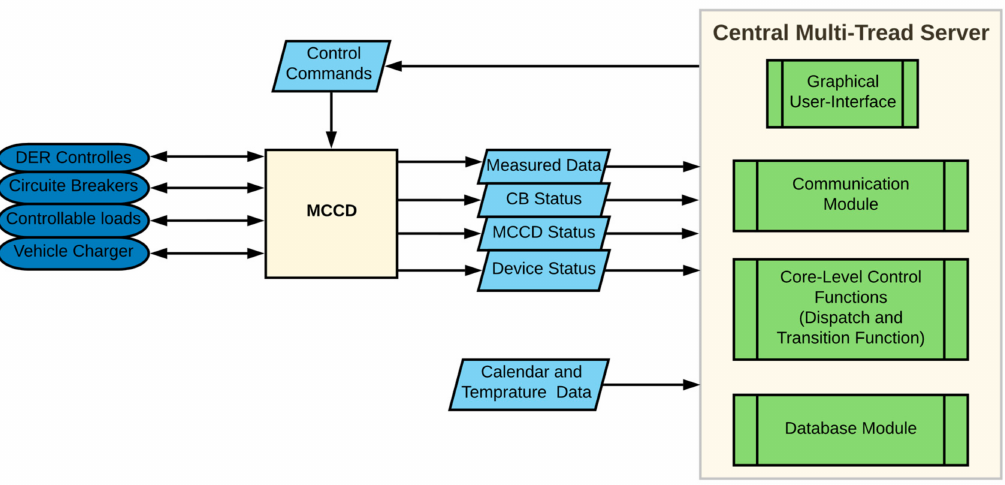
Figure 3. Data flow and interaction within main parts of the